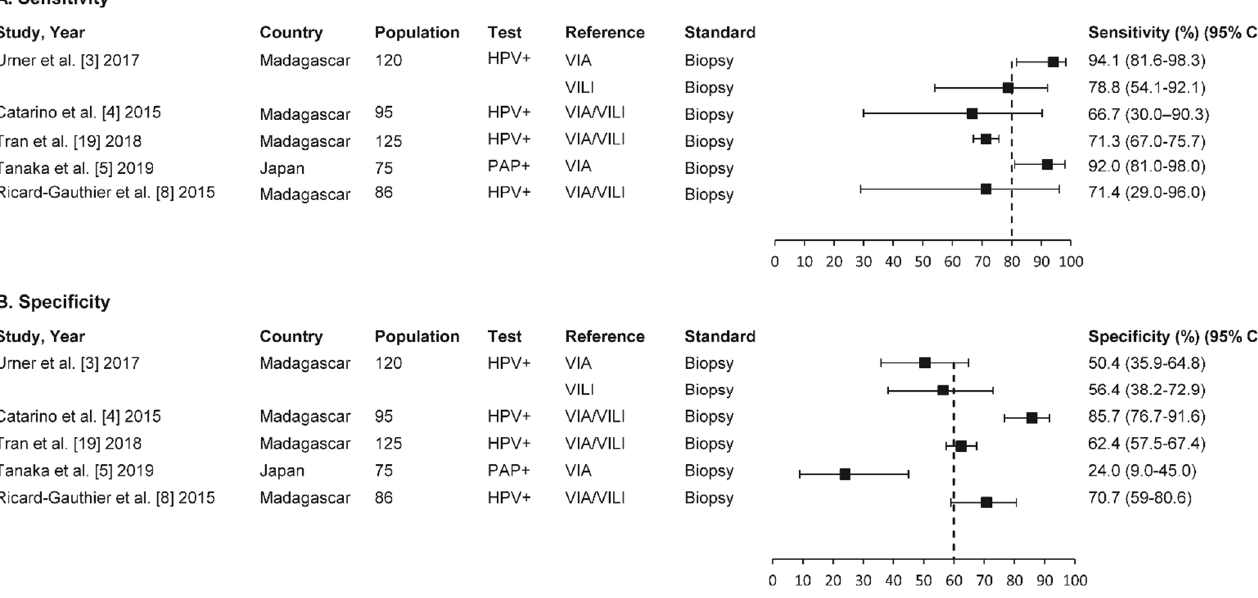
Figure 3. Summary of sensitivity ( A ) and specificity in five studies ( B ). VIA: visual inspection with acetic acid; VILI: visual inspection with Lugol’s iodine; CIN: cervical intraepithelial neoplasia; CI: confidence interval.